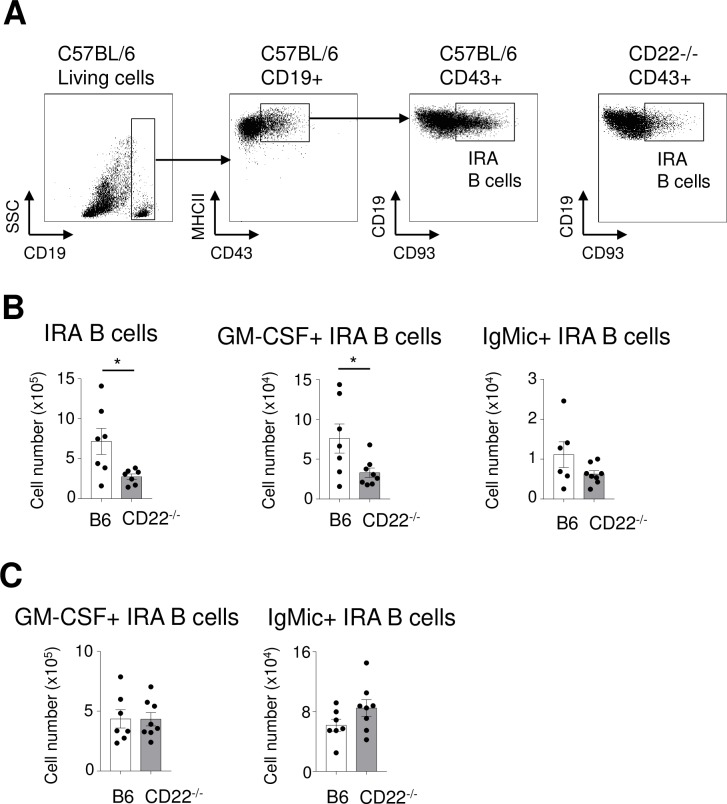
CD22-deficient mice have a lower number of GM-CSF producing IRA B cells in the lungs after pneumococcal infections.C57BL/6 control and CD22-/- mice (C57BL/6 background) were infected with 1 x 105 CFU S. pneumoniae intranasally and were analysed 72 hours after infection. (A) IRA B cells (MHCII+, CD19+, CD43+, CD93+) were identified in lung and spleen, as indicated for lung. (B) IRA B cells and GM-CSF+ and intracellular IgM+ (IgMic+) B cells were quantified in the lung. (C) GM-CSF+ and intracellular IgM+ (IgMic+) B cells were quantified and in the spleen. For B) and C) total cell numbers were calculated as percentage of total leukocyte numbers. * = p<0.05. n = 7 (C57BL/6) or n = 8 (CD22-/-) mice were used. A representative of two experiments is shown.